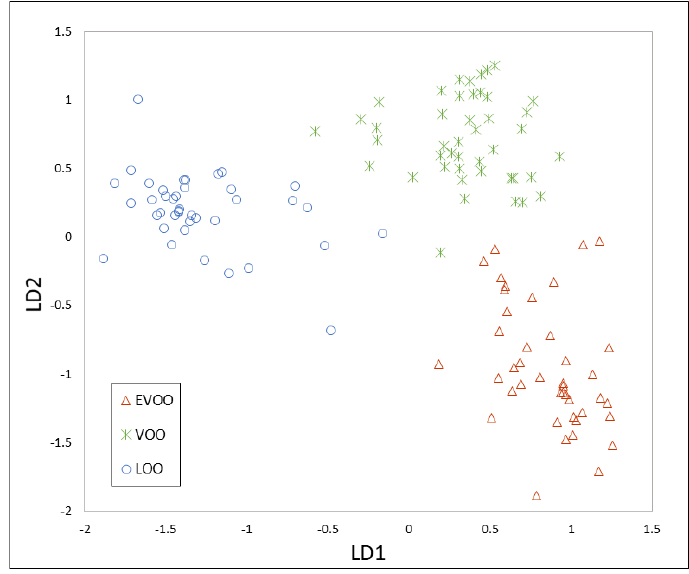
Figure 4. PCA-LDA model constructed using the peak integration of the HS-GC-MS method.